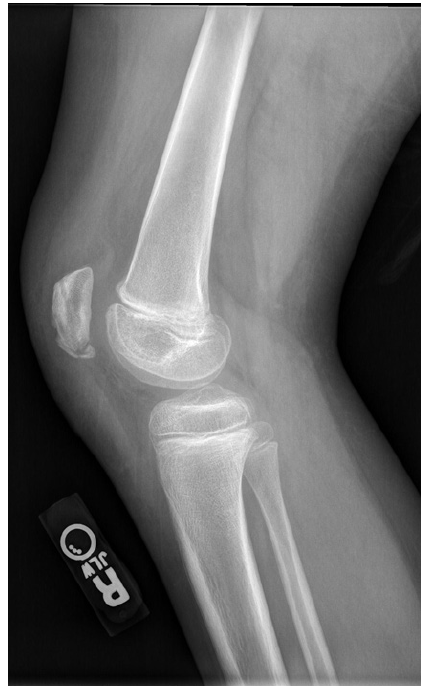
Figure 2. This is the post-surgical fixation lateral view of the patient’s knee demonstrating resolution of patella alta and fixation of the ossific fragment.